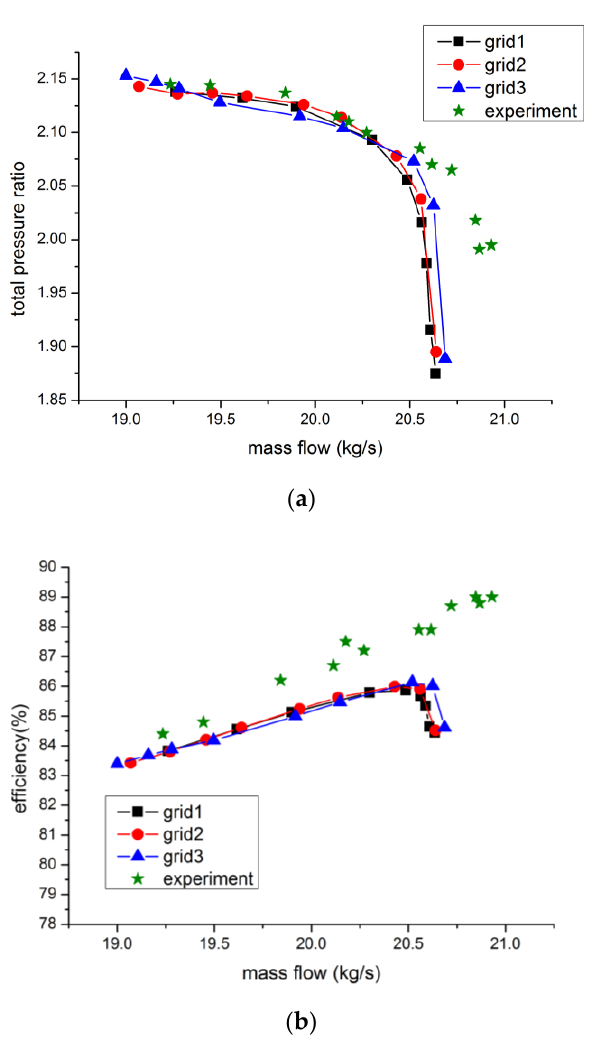
Figure 4. Characteristic curves for calculation and experiment. ( a ) Total pressure ratio characteristic curves; ( b ) efficiency characteristic curves.